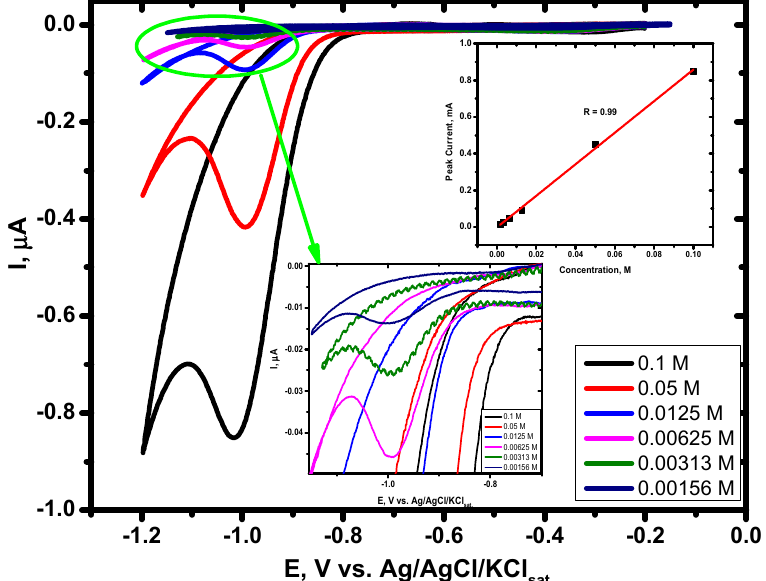
Figure 9. CV of 0.1 M NaOH on AgPtCo/GCE at 50 mV/s, at different nitrate ions concentrations. The insert figure is the relation between nitrate concentration in M and the electrochemical reduction peak current.